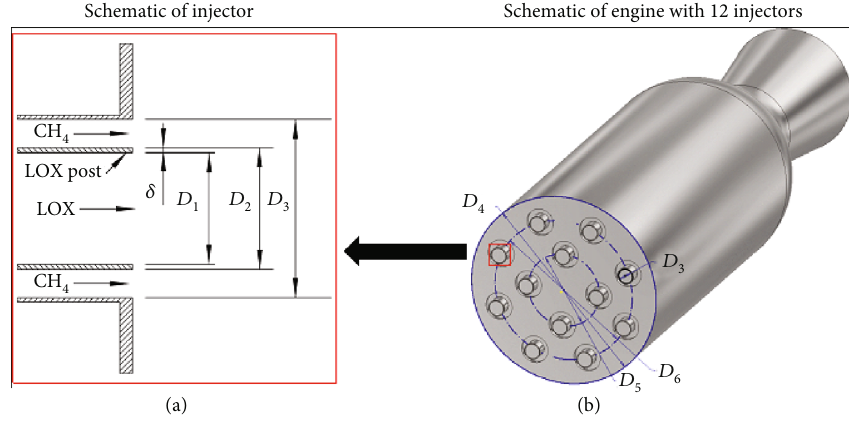
Figure 2: Schematic of engine model and